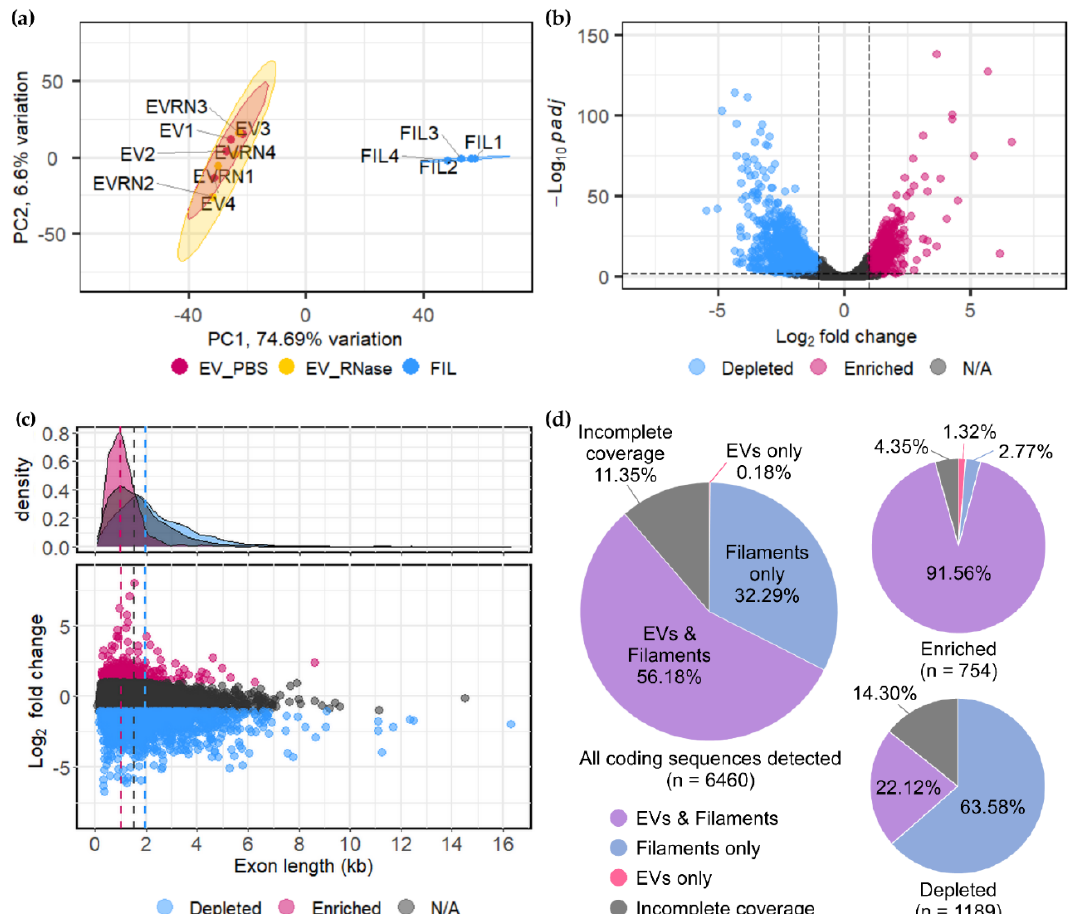
Figure 3. mRNA content of EVs is distinct from that of the hyphal filaments from which they originate. ( a ) Principal component analysis representing “differential expression” or differential presence of mRNAs in four corresponding sets of mock (EV_PBS; red) and RNase-treated (EV_RNase; yellow) EV samples and hyphal filament samples (FIL; blue). ( b ) Volcano plot of transcripts relatively enriched within EVs (red; n = 758, log2 fold change ≥ 1, padj < 0.01) and depleted from EVs (blue; n = 1189, log2 fold change ≤ − 1, padj < 0.01) compared to hyphal filaments. ( c ) Effect of transcript length on mRNA enrichment in EVs (log2 fold change). The median length of enriched transcripts is 1.002 kb (red dotted line), is shorter compared to 2.082 kb for depleted transcripts (blue dotted line; Wilcoxon rank sum test, W = 775462, p -value = 3.77 × 10 − 108 ) and 1.523 kb for those neither enriched nor depleted (grey dotted line; log2 fold change > − 1 and < 1, Wilcoxon rank sum test, W = 1109078, p -value = 2.26 × 10 − 55 ). ( d ) Percentage of transcripts with full read coverage of the coding sequences (CDS); the entire coding region should be covered by at least one read per nucleotide position in at least one out of four biological replicates. Pie charts are shown for all 6460 coding transcripts detected in EVs and for those relatively enriched in EVs and depleted from EVs.